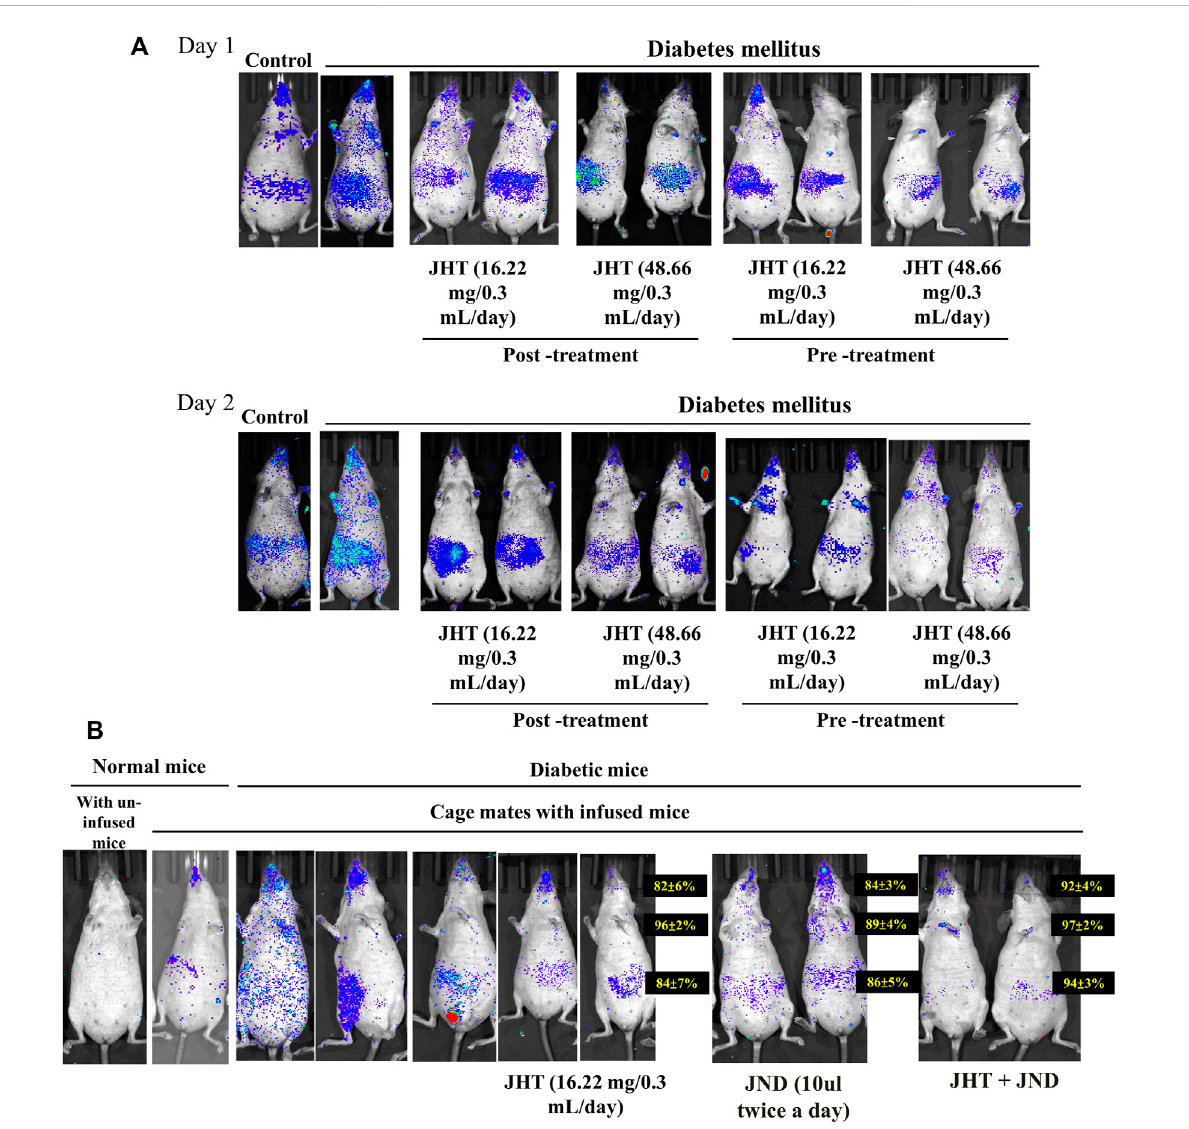
Effect of JHT and JND on the viral accumulation in diabetic SKH-1 mice and combined effect of JHT and JND on the transmission of SARS- CoV2-S- gamma variant: Viral load in diabetic SKH-1 mice (n = 9) with or without 16.22 mg and 48.66 mg post-treatment/pre-treatment of